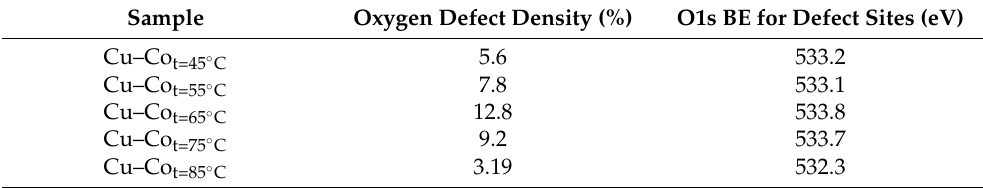
Table 2. Oxygen defect density of